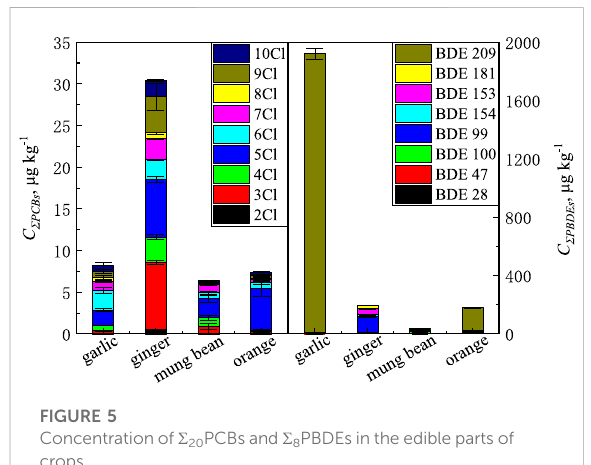
Concentration of Σ 20 PCBs and Σ 8 PBDEs in the edible parts of crops.